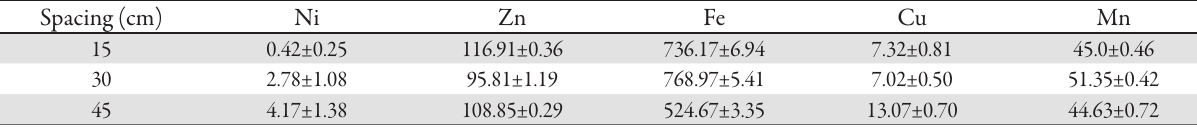
Tab. 4. Concentration of heavy metals (mg/kg) during the vegetative stage in S. officials L. cultivated under different intra-row spacing in Shoubak region south of Jordan (Abu-Darwish et al. ,